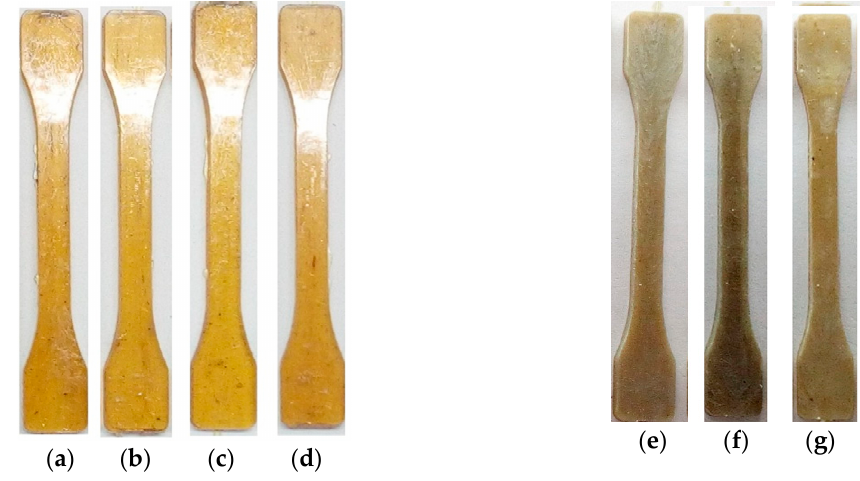
Figure 5. Samples from composites PEI/OPSU ( a – d ) and PEI/PC ( e – g ).